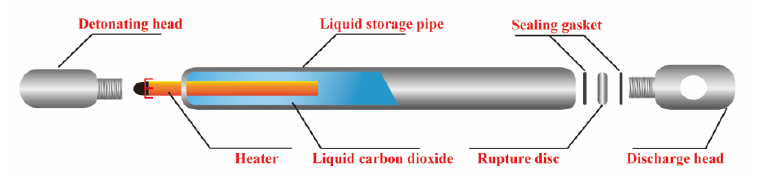
Figure 1. Structure diagram of carbon dioxide phase transition fracturing pipe.